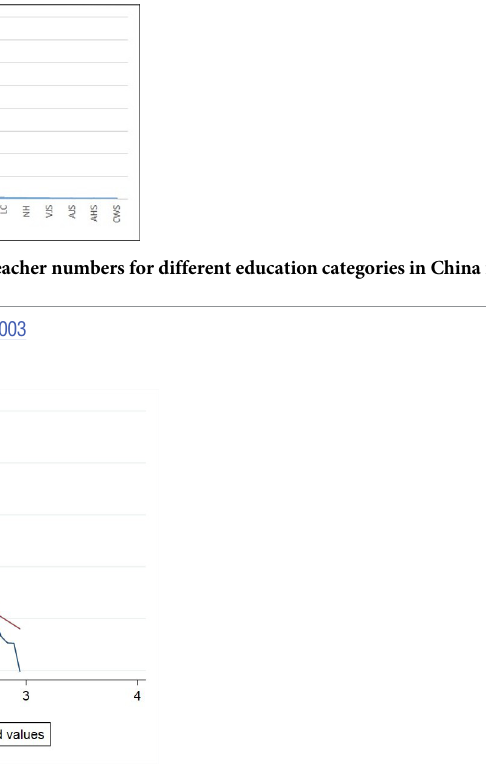
Fig 4. The double logarithmic distribution curve of full-time teacher numbers for different education categories in China from 2003–2014.